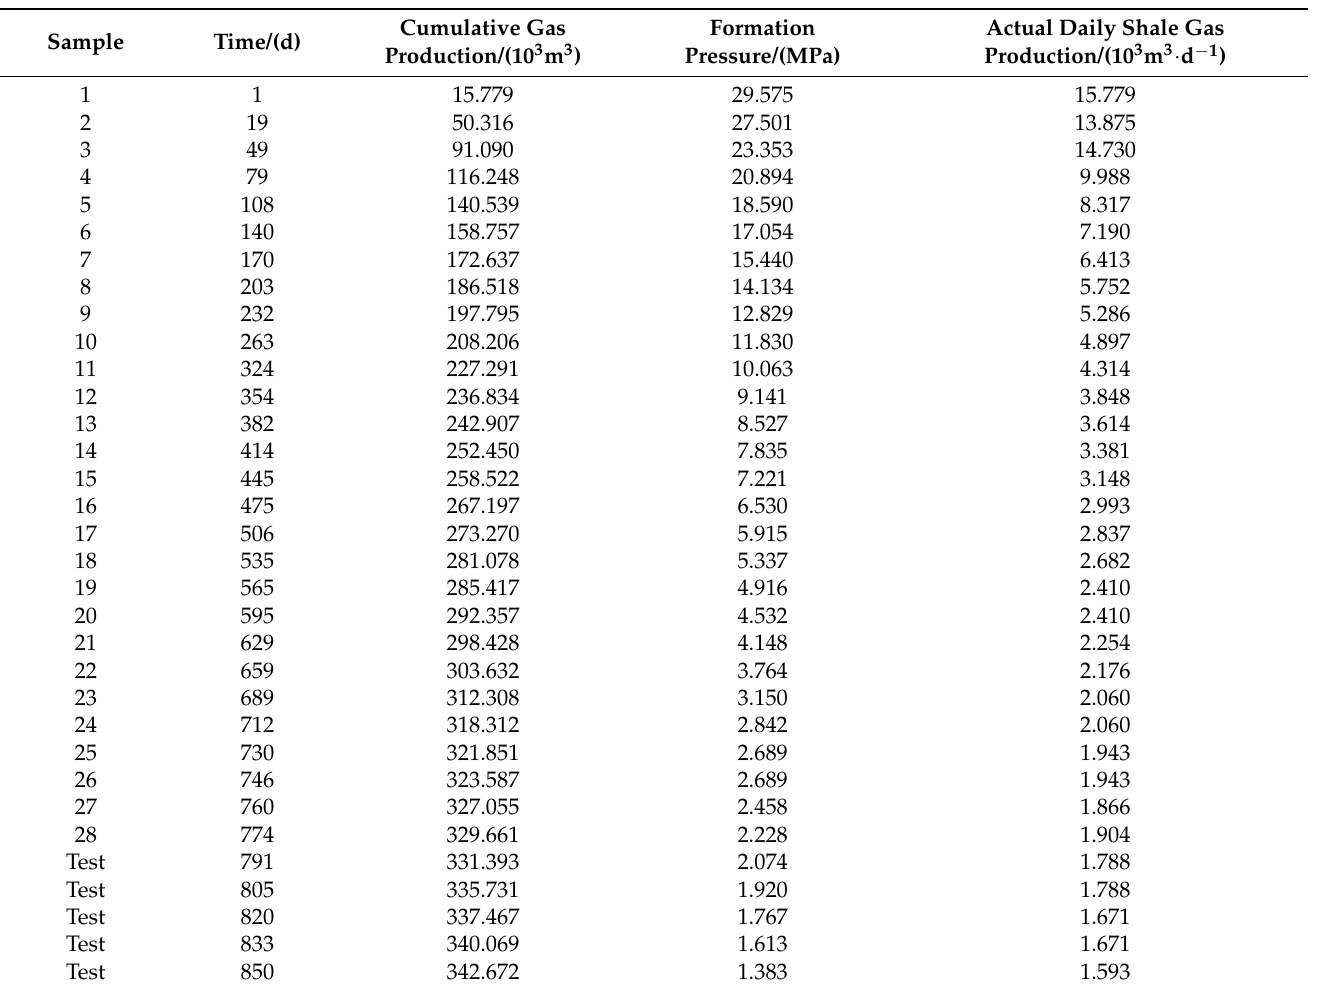
Table 1. Basic data of ANN learning training samples [28].